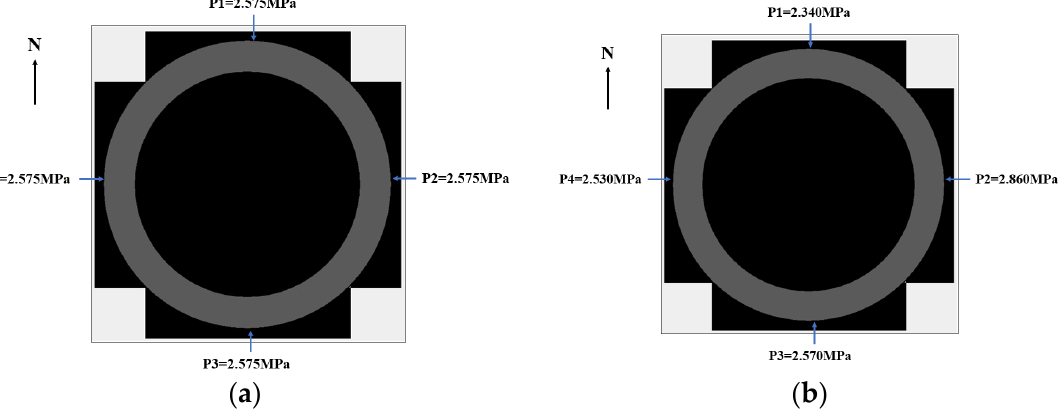
Figure 21. S1ZK0 + 735 m section RFPA load loading plan. ( a ) Uniform pressure; ( b ) Non ‐ uniform pressure.